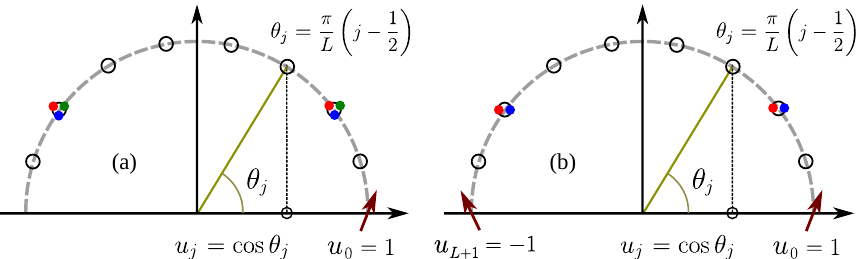
Figure 1 . Schematics of the quantum impurity models. The lattice sites in the range 1 (cid:20) j (cid:20) L are occupied by conduction fermions with N possible internal states (color). The j -th lattice site has angular position (cid:18) j = (cid:25) ( j (cid:0) 1 = 2) and its linear position on the horizontal axis is u j = cos (cid:18) j . The L arrows represent impurities in the fundamental representation of the SU( N ) group. The j = 0 site has (cid:18) 0 = 0 and the j = L + 1 site has (cid:18) L +1 = (cid:25) . (a) The model with one SU(3) impurity. The three colored dots represent conduction fermions. (b) The model with two SU(2) impurities. The two colored dots represent conduction